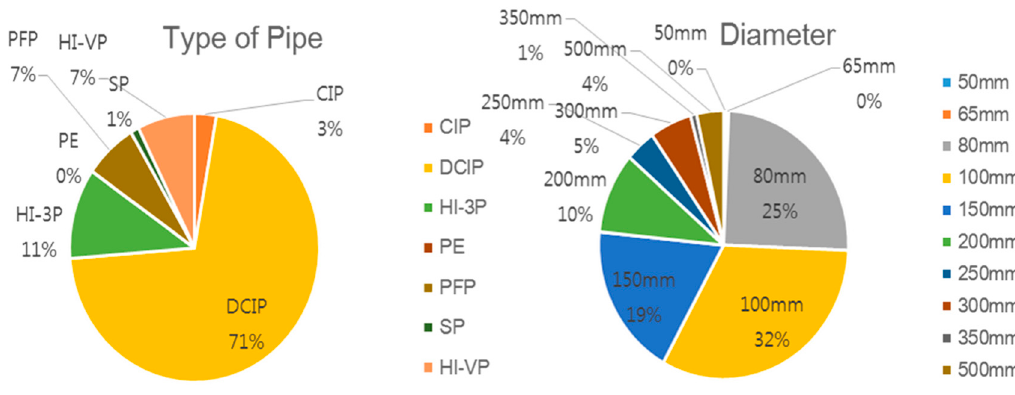
8 of 13 Figure 6. Characteristics of water transmission pipes.